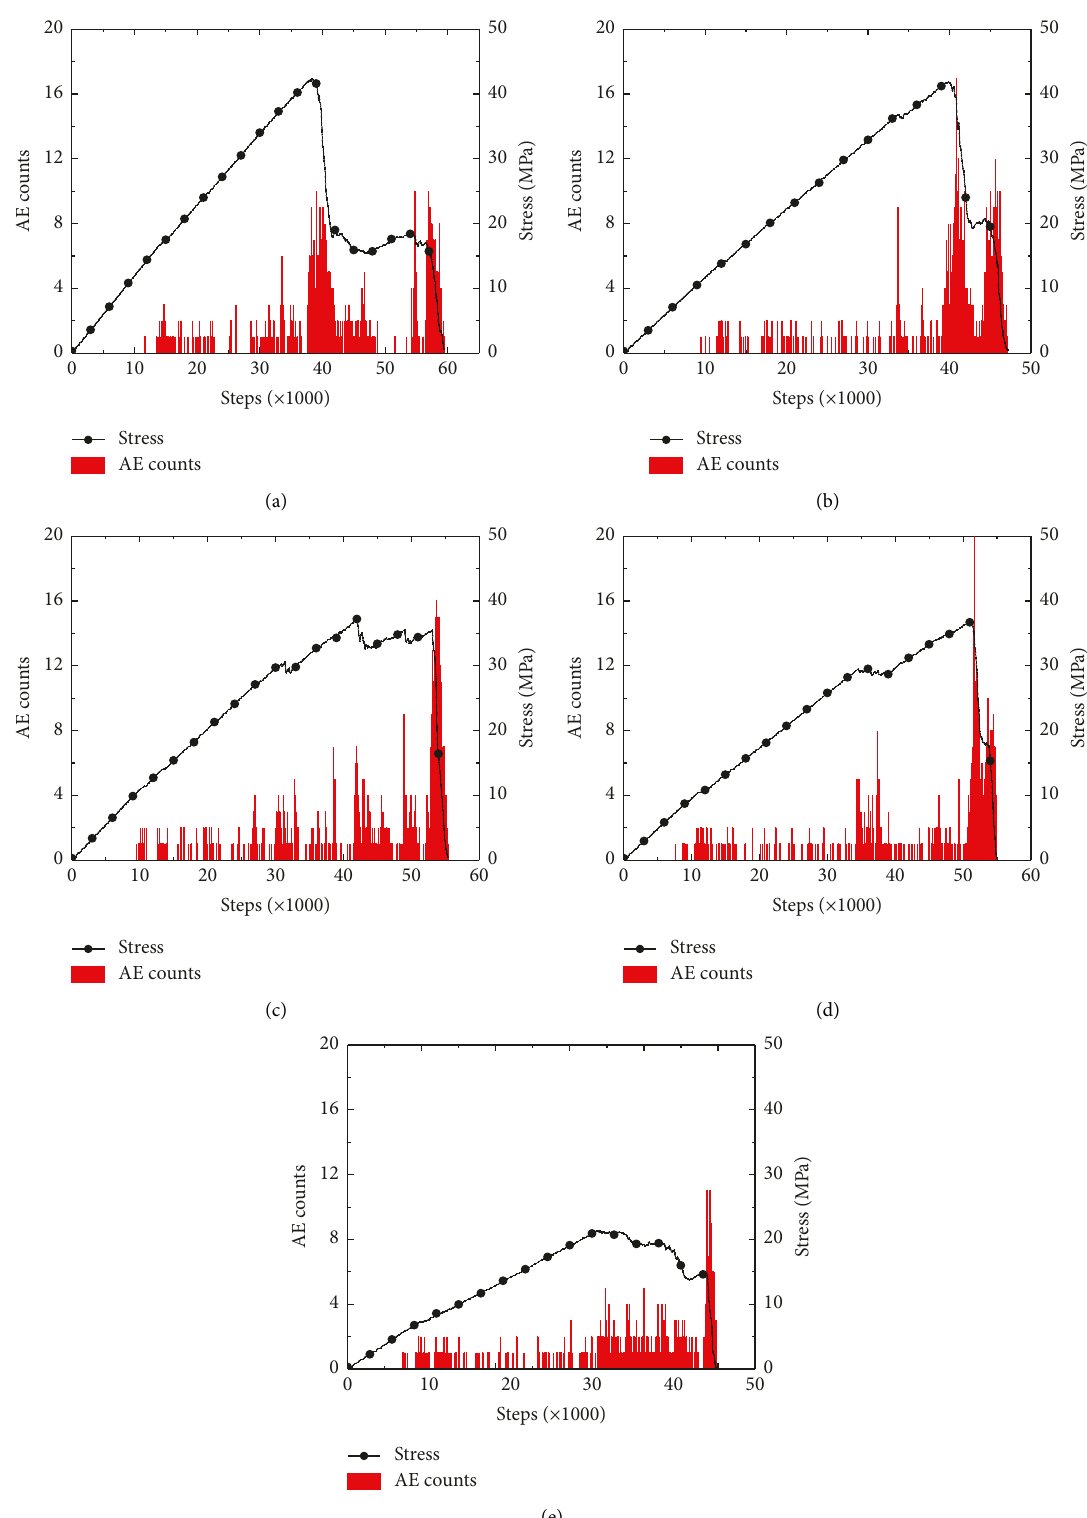
Figure 9: AE counts of rocks with different joint lengths. (a) LB � 10mm. (b)LB � 20mm. (c) LB � 30mm. (d)LB � 40mm. (e) LB �